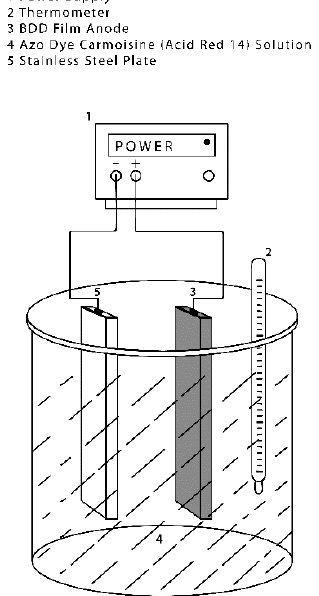
Figure 2. Schematic figure of electro-oxidation (EO) process for the degradation of the azo dye Carmoisine solution.